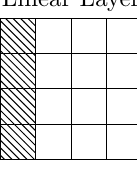
Figure 2: The output of the linear layer an adversary can observe by placing a probe in either one S-box (in the top left S-box) or in the linear layer (in the left ShiftRows and MixColumns operation) of a masked AES (where for the sake of an example, we don’t consider the S-boxes are paired). Other probe positions are similar in that an adversary can at most observe one column of the